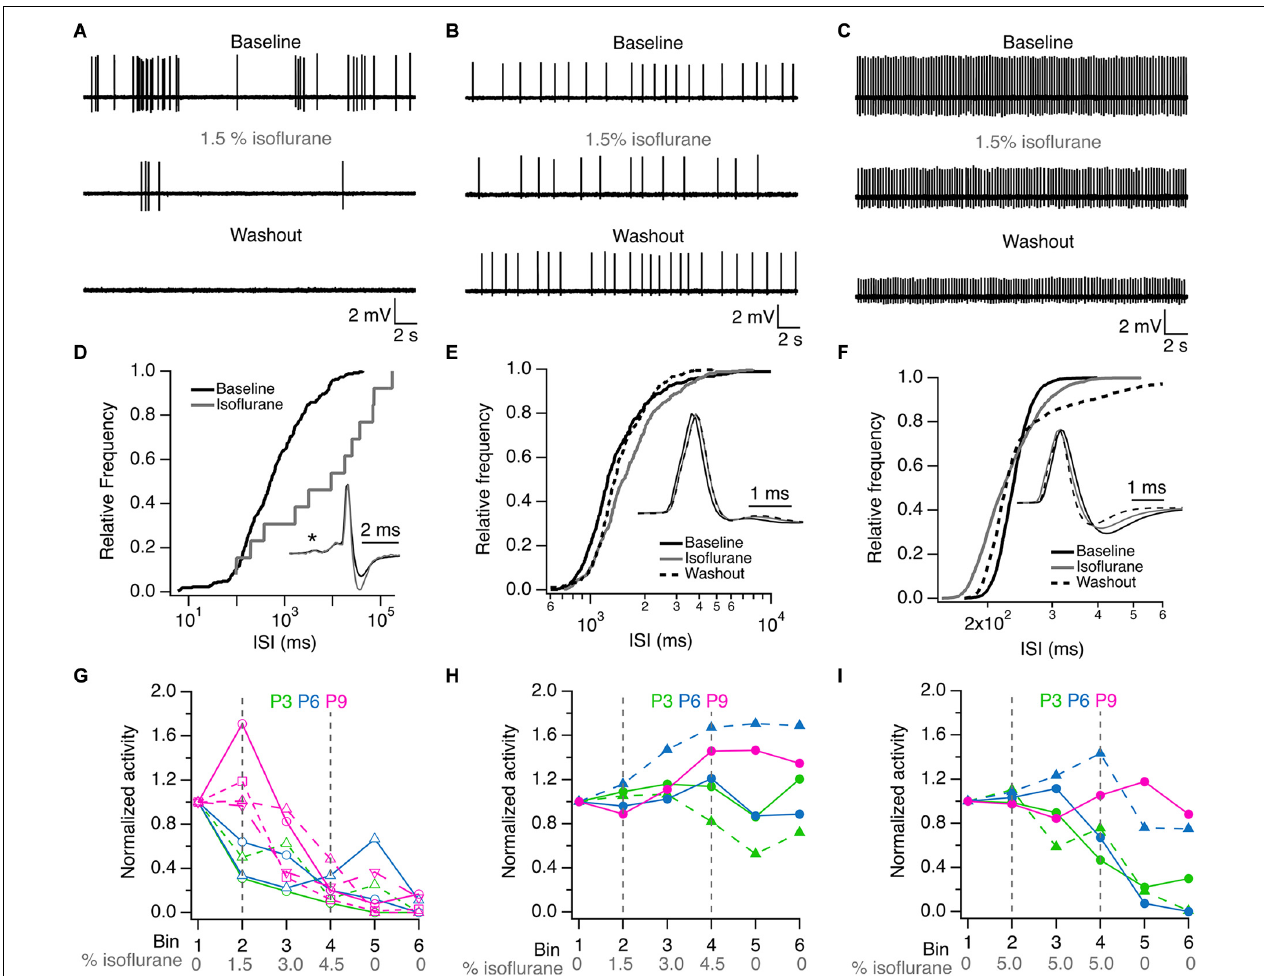
FIGURE 1 | ISO inhibit single unit activity in K/X mix anesthetized pups. (A) Burst firing unit from a P6 rat. (B) Regular firing unit from a P3 rat. (C) Regular firing unit from a P6 rat. (D) Effect of ISO on the inter-spike interval (ISI) distribution of single unit shown in (A) . (E) Effect of ISO on ISI distribution of single unit shown in (B) . (F) Effect of isoflurane on ISI distribution of single unit shown in (C) . (G) Inhibitory effect of ISO on single unit activity recorded at P3 (green), P6 (blue) and P9 (magenta). (H) ISO resistant single units recorded at P3, P6 and P9. (I) Exposure to 5% ISO inhibited 3 of 5 single units shown in (H) . ISI = inter-spike interval. Asterisk in D indicates the pre-spike in this complex waveform. Inset waveforms in (D) are averages of 269 and 11 action potentials in baseline and isoflurane, respectively. Inset waveforms in (E) are averages of 363, 330, and 392 action potentials in baseline, isoflurane and washout, respectively. Inset waveforms in (F) are averages of 2,538, 2,599, and 2,046 action potentials in baseline, isoflurane and washout, respectively. Lines and symbols in (H,I) identify the same single units under different isoflurane conditions. Vertical dashed lines in (G–I) indicate the onset and offset of isoflurane application.